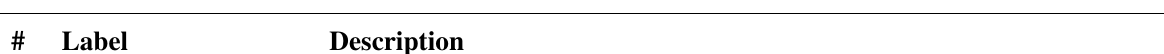
Table 1. Fall and non-fall actions (ADLs) considered in this study. Fall